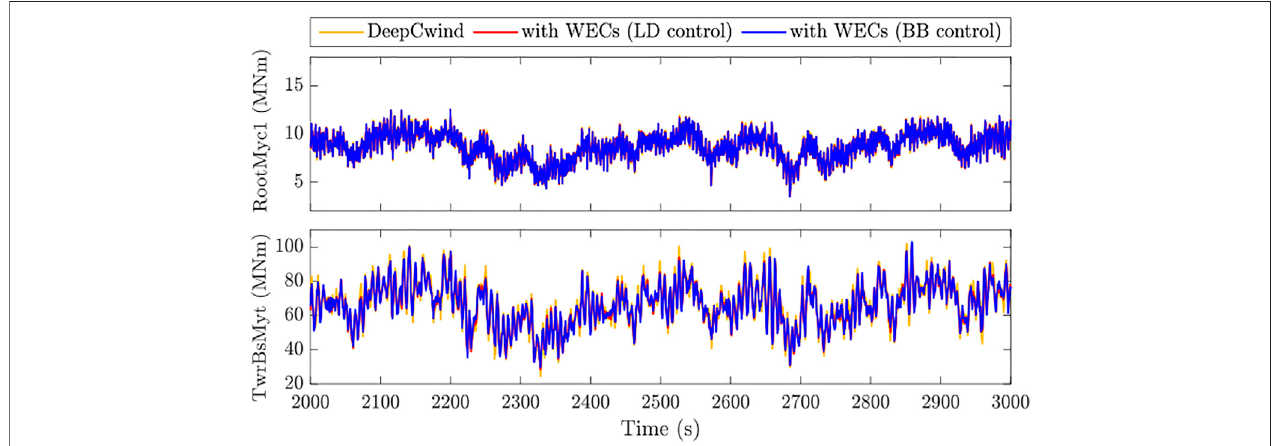
FIGURE 18 | Time series of blade-root and tower-base loads in DLC 2.